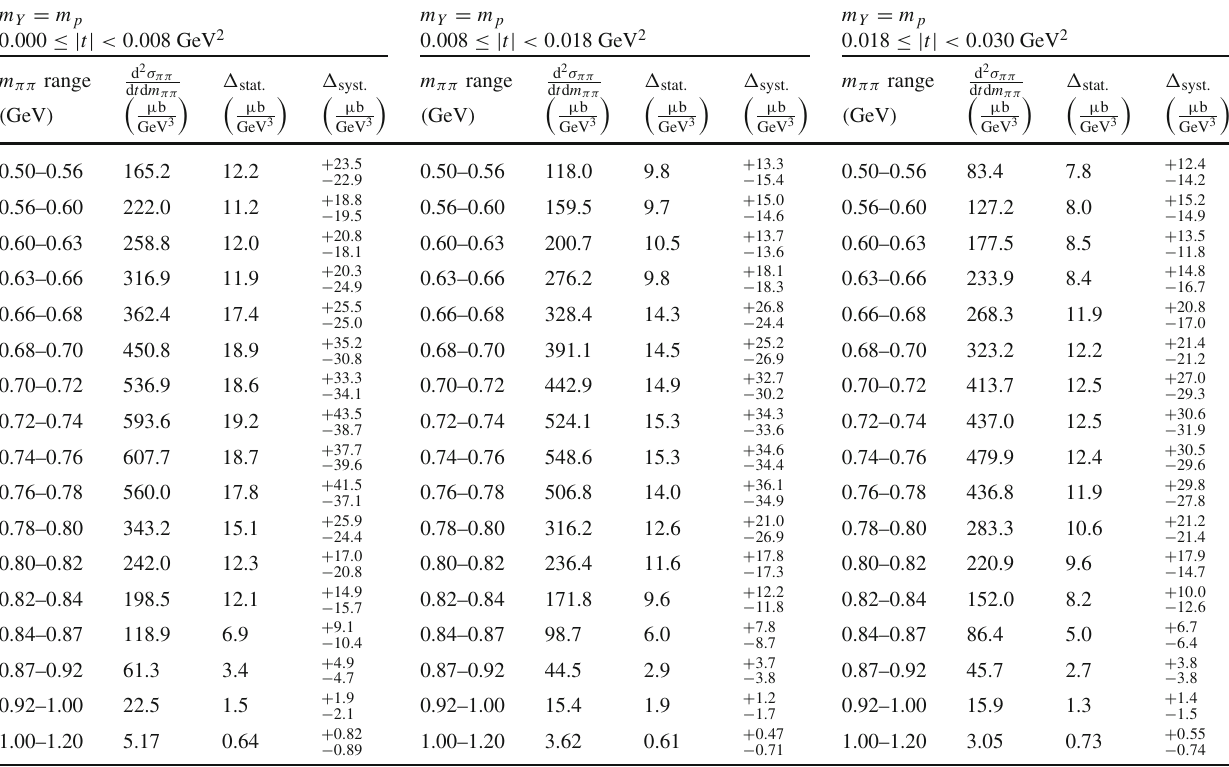
Table20 Unfoldedelastic( m Y = m p )double-differential π + π − photo- and t . The cross section is measured in the fiducial phasespace defined in Table 3 and calculated according to Eq. (28). The statistical and full